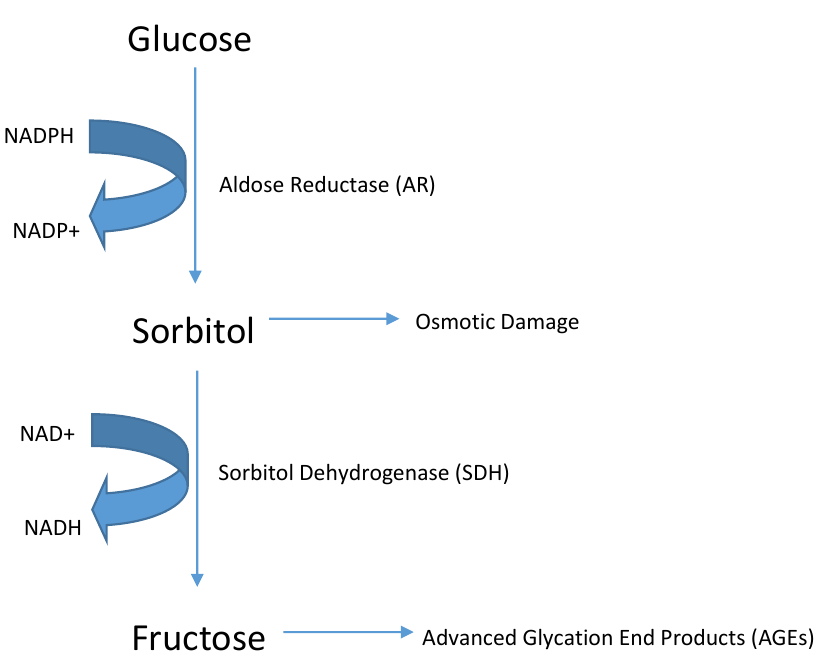
Figure 1. The human aldose reductase (AR). Quantum model of catalysis based on mobile proton revealed by subatomic X-ray and neutron diffraction studies of human aldose reductase (h-AR). The structure presents results of combined studies of the enzyme human aldose reductase (h-AR, 36 kDa) using single-crystal X-ray data (0.66 A, 100 K; 0.80 A, 15 K; 1.75 A, 293 K), neutron Laue data (2.2 A, 293 K), and quantum mechanical modeling. These complementary techniques unveiled the internal organization and mobility of the hydrogen bond network that defines the properties of the catalytic engine, explaining how AR overcomes the simultaneous requirements of efficiency and promiscuity and thus offering a general mechanistic view for this class of enzymes [1], doi:10.2210/pdb2R24/pdb.